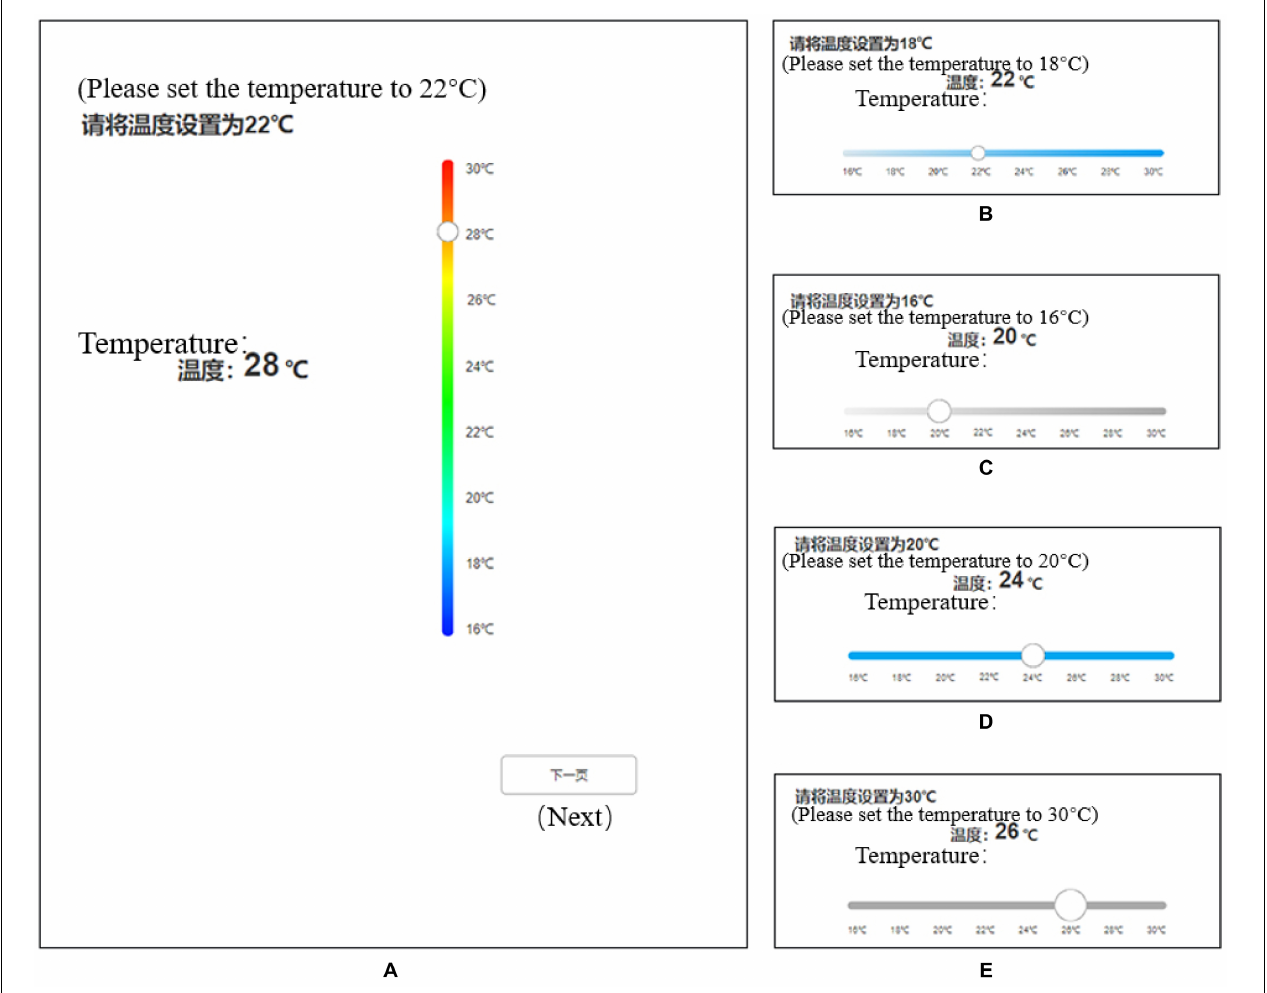
FIGURE 2 | Examples of the screenshot for the experimental touchscreen interfaces. As shown in (A) , the experimental task is to adjust the temperature according to the text prompt at the top of the page by dragging the slider to the specified temperature. After completing the task on the page, the pilot presses the “Next” button to continue. (A–E) Present experimental material styles of different button sizes, track colors, and sliding orientation. English words in parentheses are used for explanation only and would not be shown in the